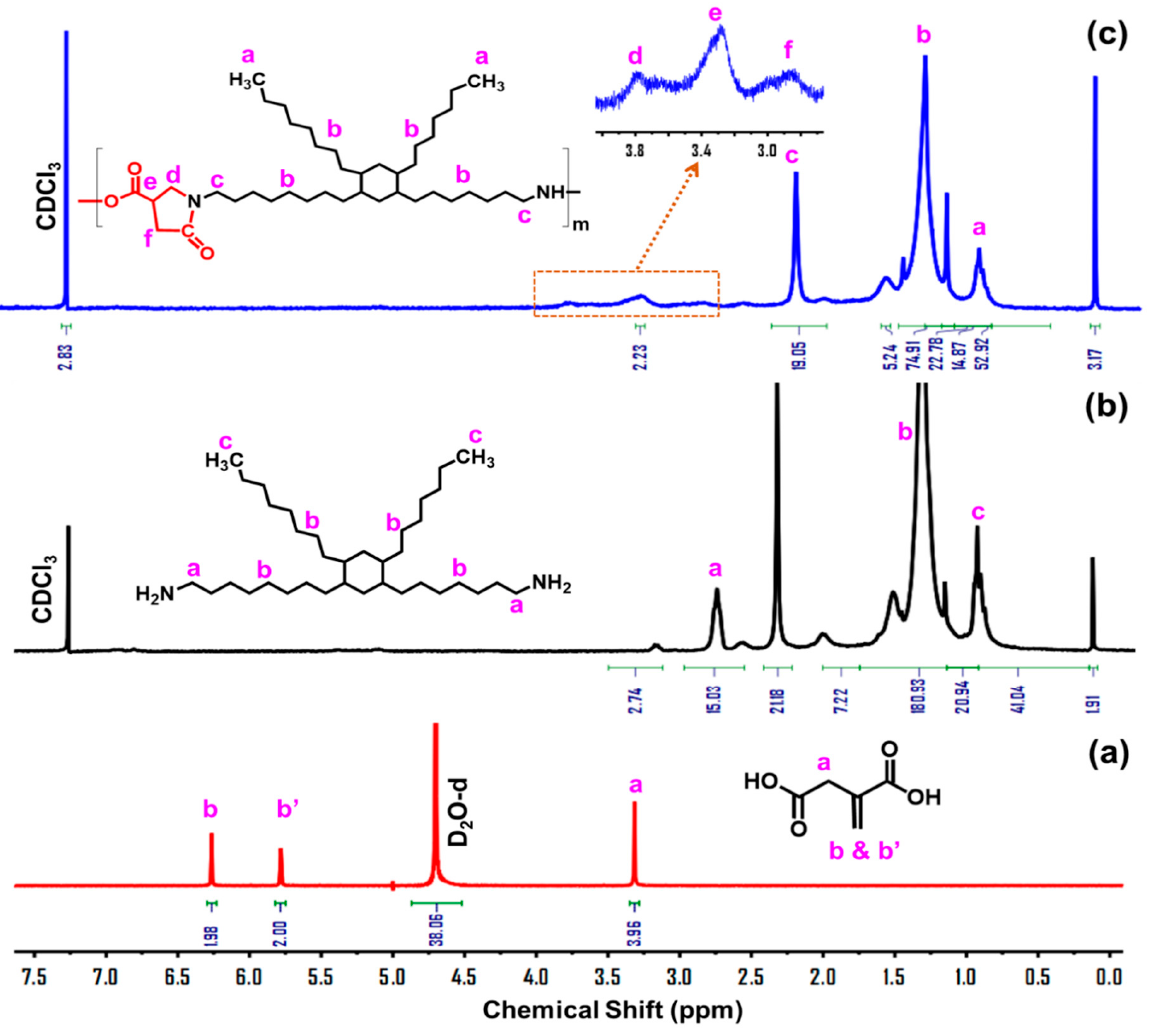
Figure 2. 1 H NMR spectra of ( a ) IA, ( b ) Priamine TM 1075, and ( c ) PA36,IA.